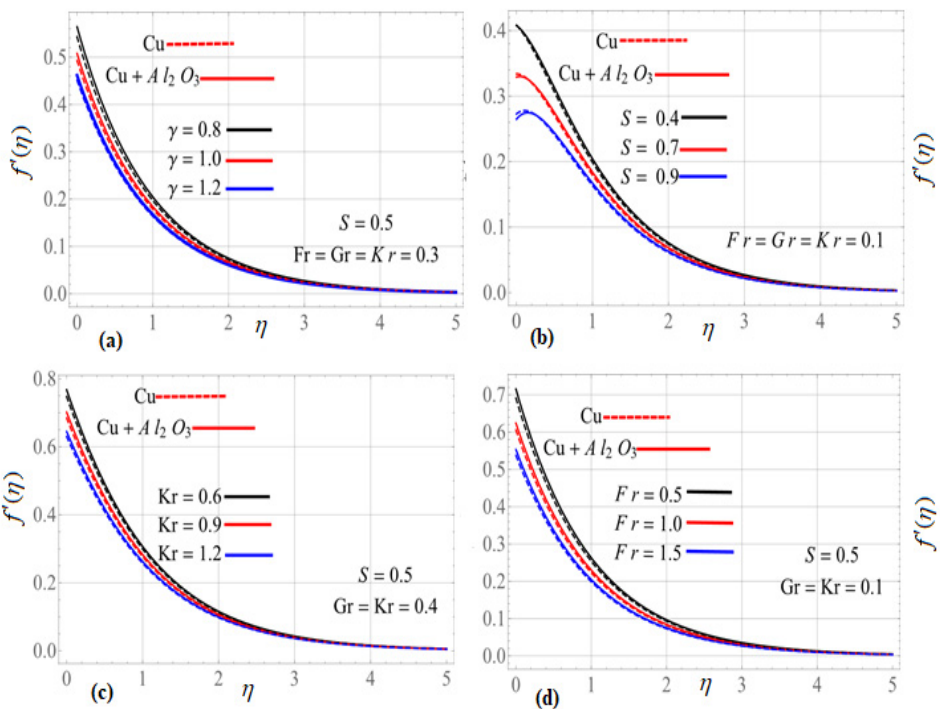
( ) γ / Cu Al O H O + versus / Cu H O . F η ′ for on 2 3 2 2 ( ) / Cu Al O H O + versus / Cu H O . F η ′ for on 2 3 2 2